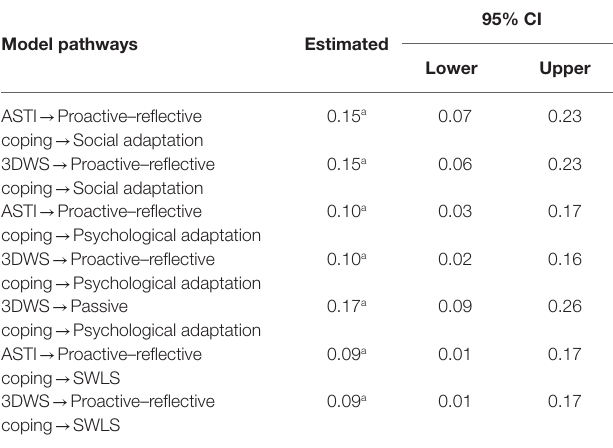
TABLE 3 | Standardized indirect effects and 95% CI for the mediation model.